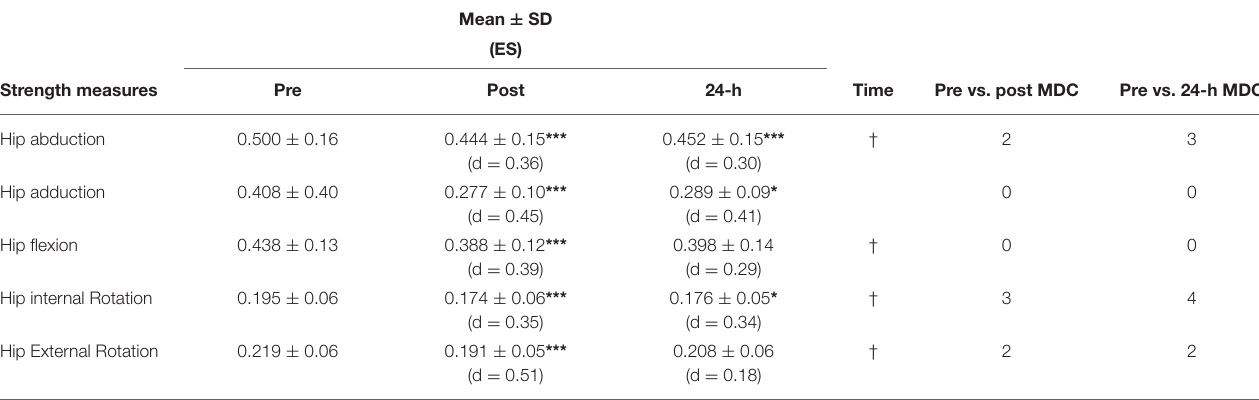
TABLE 2 | Hip strength measures, body mass-normalised (kg.kg − 1 ) represented as mean (ES; Cohen’s d ) and individuals exceeding minimum detectable change (MDC) for each variable at post and 24-h post compared to pre.